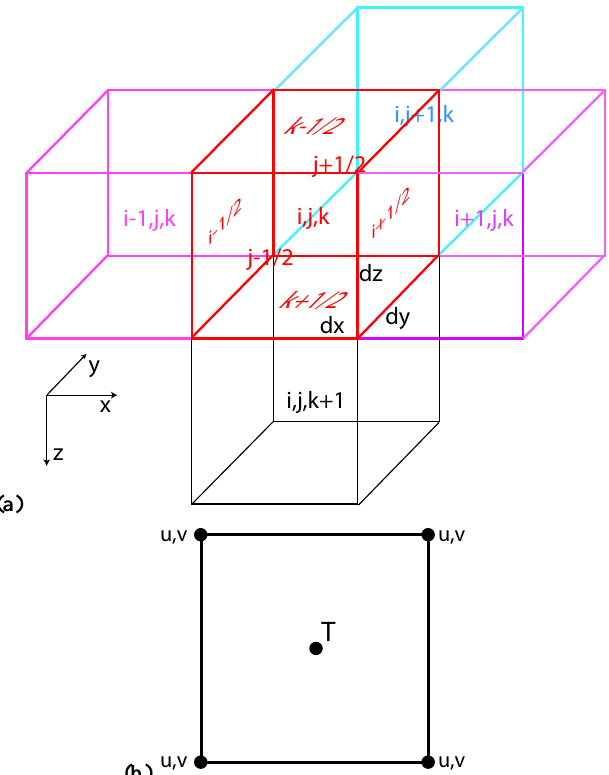
Fig. 2. (a) Model grid box around the point i,j,k ; i increases with longitude, j with latitude and k with model depth. The length of each side of the box are given by d x , d y and d z , and interfaces between boxes are represented by i + 1 arrangement of tracer (temperature) and velocity components in the Arakawa